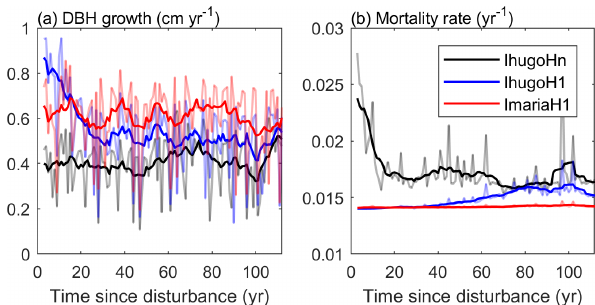
Figure 11. Times series of (a) average growth rate and (b) mortal- ity rate of Late trees with DBH ≥ 20cm. The light-colored lines represent the yearly values, and the solid lines are 10-year moving